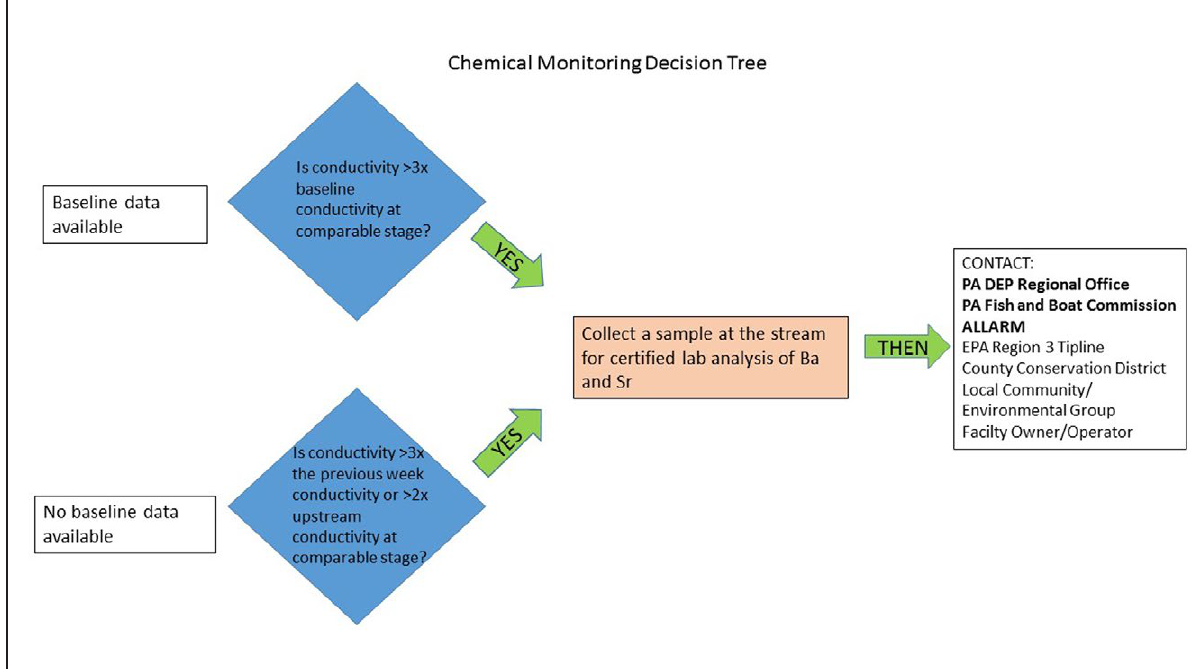
Figure 6: An example of a decision tree that volunteers follow when they identify a possible pollution event based on water chemistry. Decision trees also are available for visual assessment and pipeline observational monitoring (Wilderman and Monismith